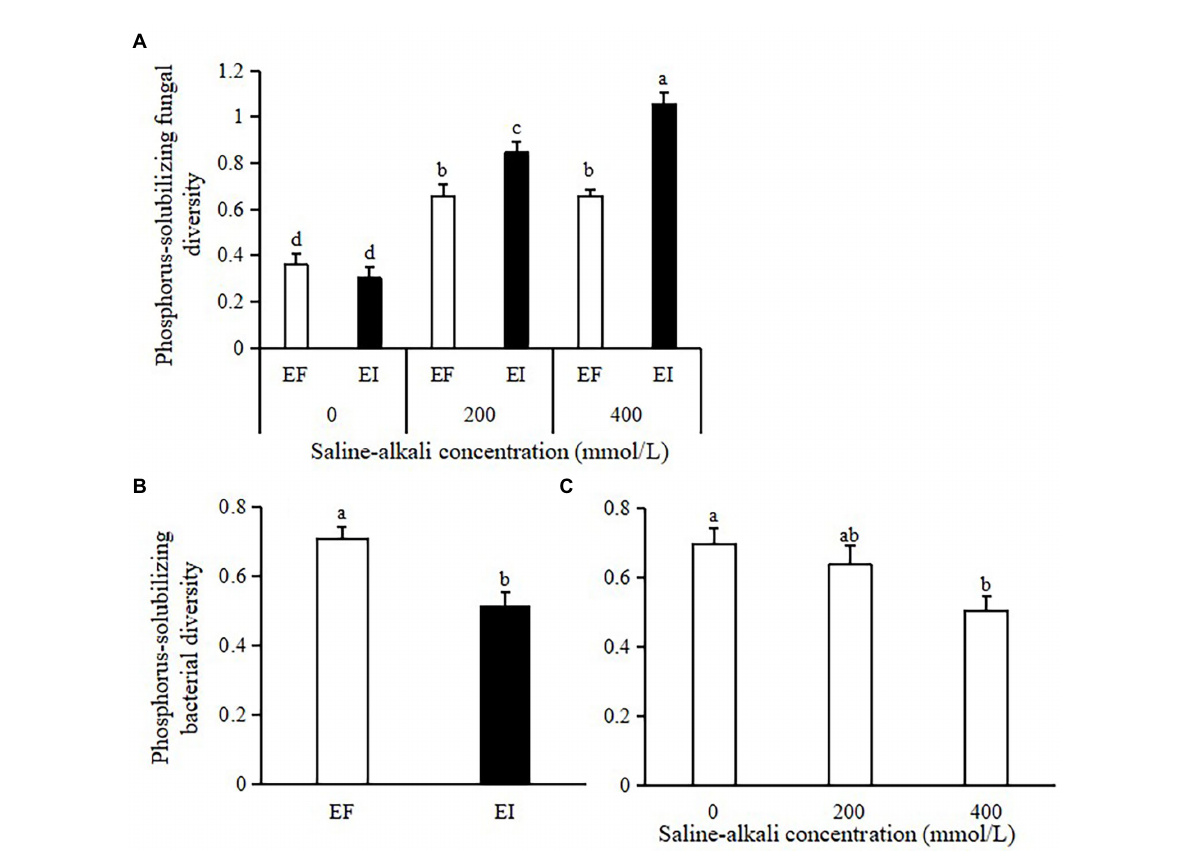
FIGURE 2 Effects of the interaction between Epichloë endophyte and saline-alkali stress on phosphorus solubilizing fungal (PSF) diversity in tall fescue roots (A) , and effects of Epichloë endophyte (B) and saline-alkali stress (C) on phosphorus solubilizing bacterial (PSB) diversity in tall fescue roots. Different letters denote means that are significantly different ( p <